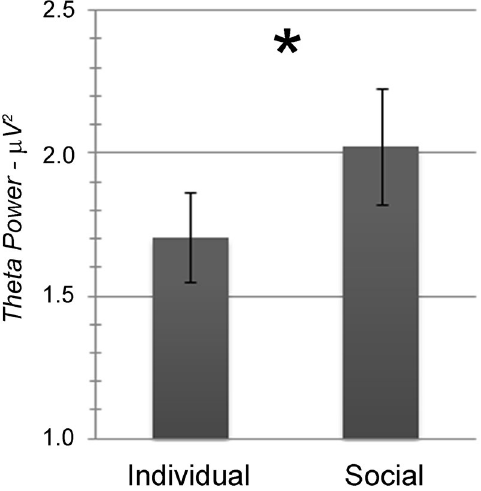
Figure 3. Significant modulation of EEG theta activity during the feedback phase depending on the experimental condition: Individual vs . Social. Bars represent ± 1SE; the star marks statistically significant